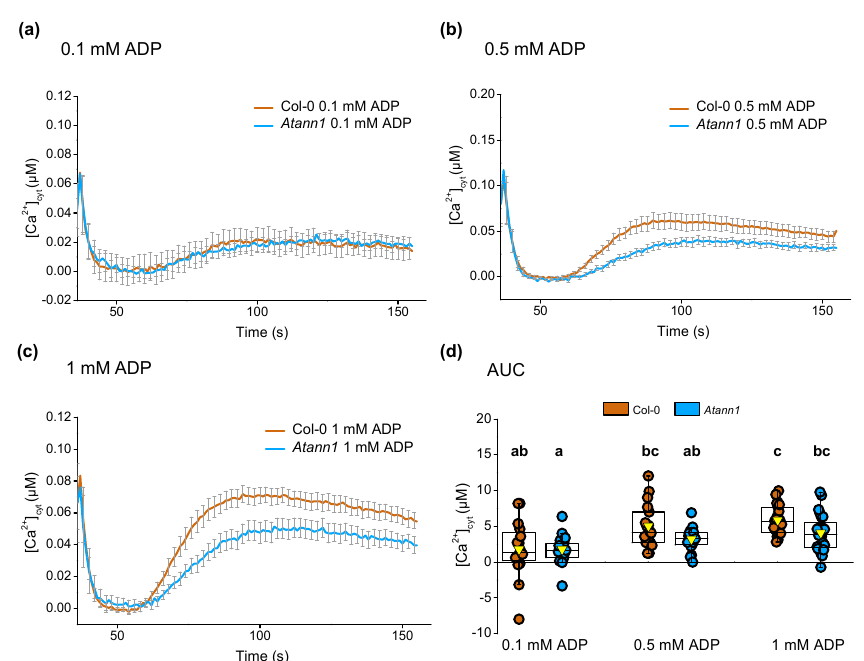
Figure 10. AtANN1 is not involved in mediating eADP-induced [Ca 2+ ] cyt increase in leaves. Mean ( ± SEM) time course of [Ca 2+ ] cyt increase (t = 36s–155s) when 14-day-old individual leaves were treated with ( a ) 0.1 mM eADP, ( b ) 0.5 mM eADP or ( c ) 1 mM eADP agonist. ( d ) The total [Ca 2+ ] cyt accumulated over the period of measurement for each concentration by calculating the AUC. Data were obtained from four experiments (Col-0 n = 16–23; Atann1 n = 17–24). The middle line of the boxplot represents the median whereas the inverted triangle represents the mean. p -values were obtained from ANOVA with Tukey’s post-hoc test. Different lower-case letters indicate a significant difference between means ( p < 0.05).